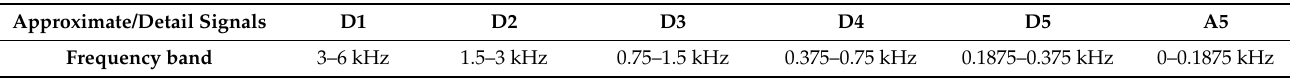
Table 2. The frequency bandwidths of approximate signals and detail